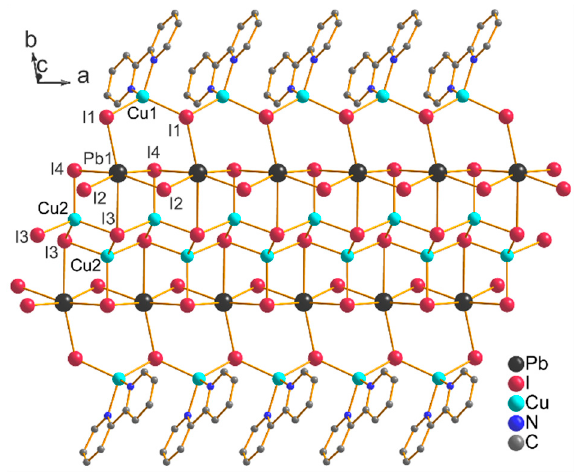
Figure 2. The fragment of the structure of 1 extending along the a axis. All H atoms have been omitted for clarity.